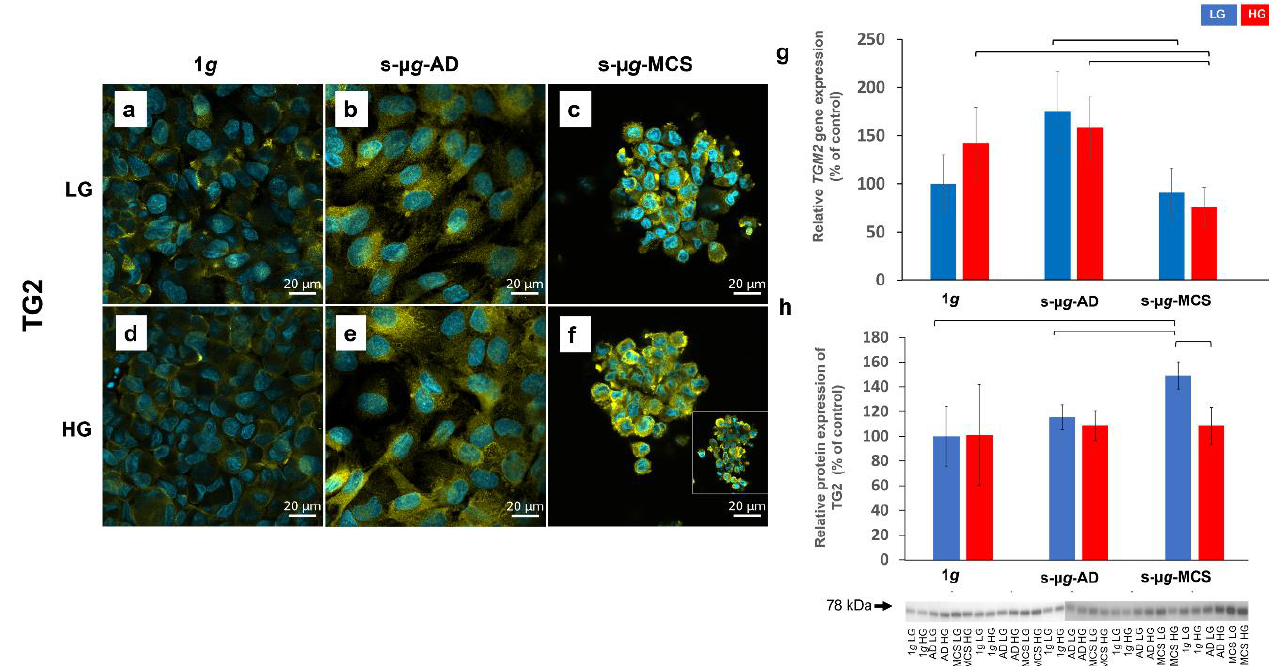
Figure 5. Analysis of TG2 after 14 days of cultivation either at 1 g or s-µ g and either using low (LG) or high (HG) glucose medium. Data were obtained via immunostaining ( a – f ), qPCR ( g ), and Western blot ( h ) techniques. The brackets represent a significance level of p < 0.05.